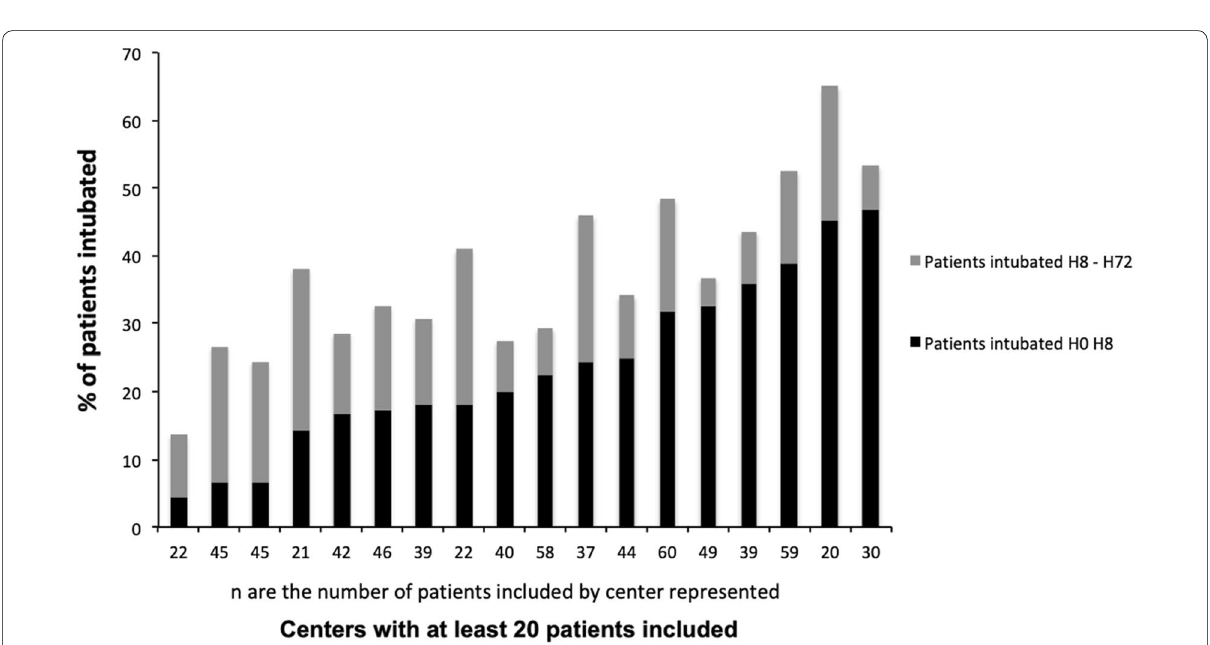
Fig. 2 Percentage of patients intubated at H8 and H72 in the 18 centers with at last 20 patients